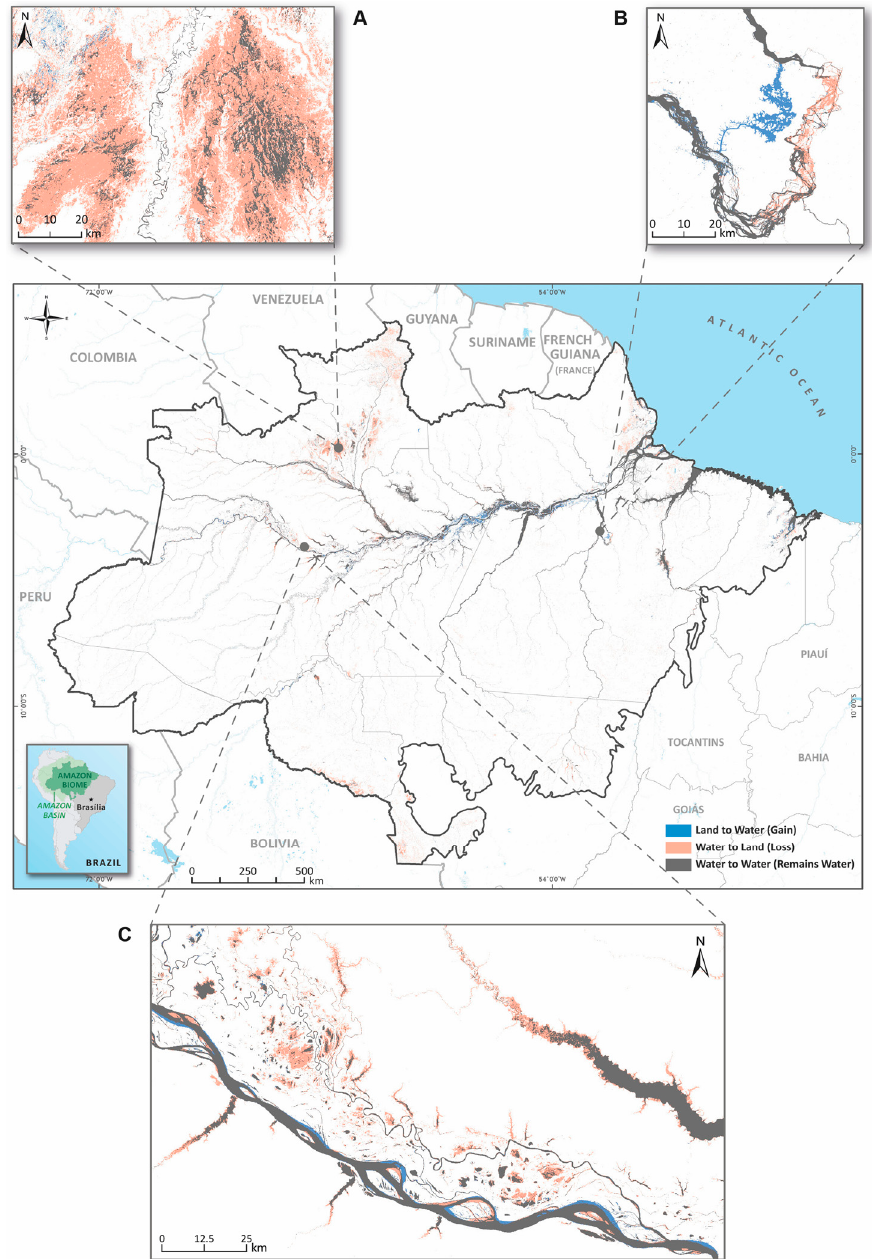
Figure 6. Interchange between water and land detected between 1991 and 2017, which are the highest and lowest surface water extent, respectively. Orange areas represent areas that changed from water in 1991 to land in 2017, and blue ones are changes from land to water between these years. In panel ( A ) wetlands changed from Water to Land; in ( B ) Land to Water associated with the construction of Belo Monte hydroelectric dam and Water to Land along the rivers that had the water flow diverted by the dam construction; and in ( C ) mostly Water to Land in flood plains along lakes and rivers.